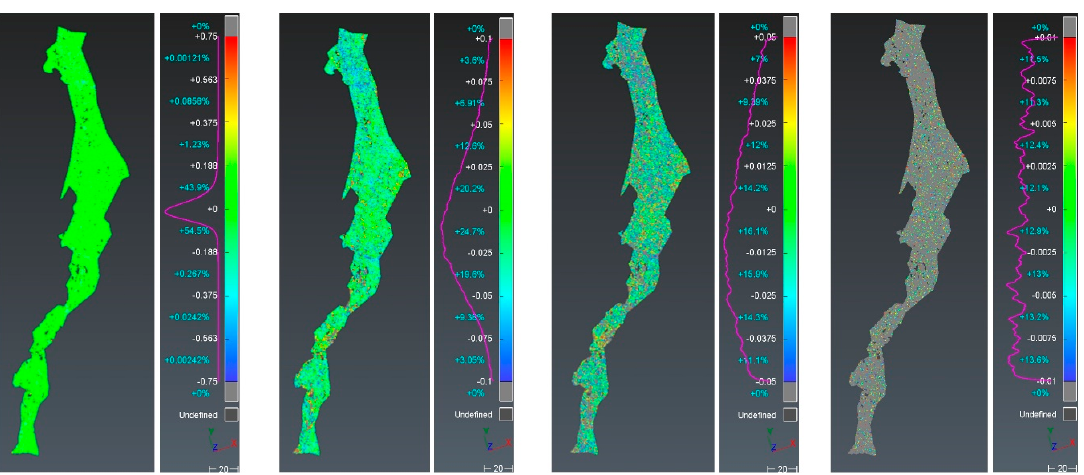
Figure 17. Height comparison of UAS and ALS point clouds in the range up to 750 mm; up to 100 mm; up to 50 mm; and up to 10 mm.